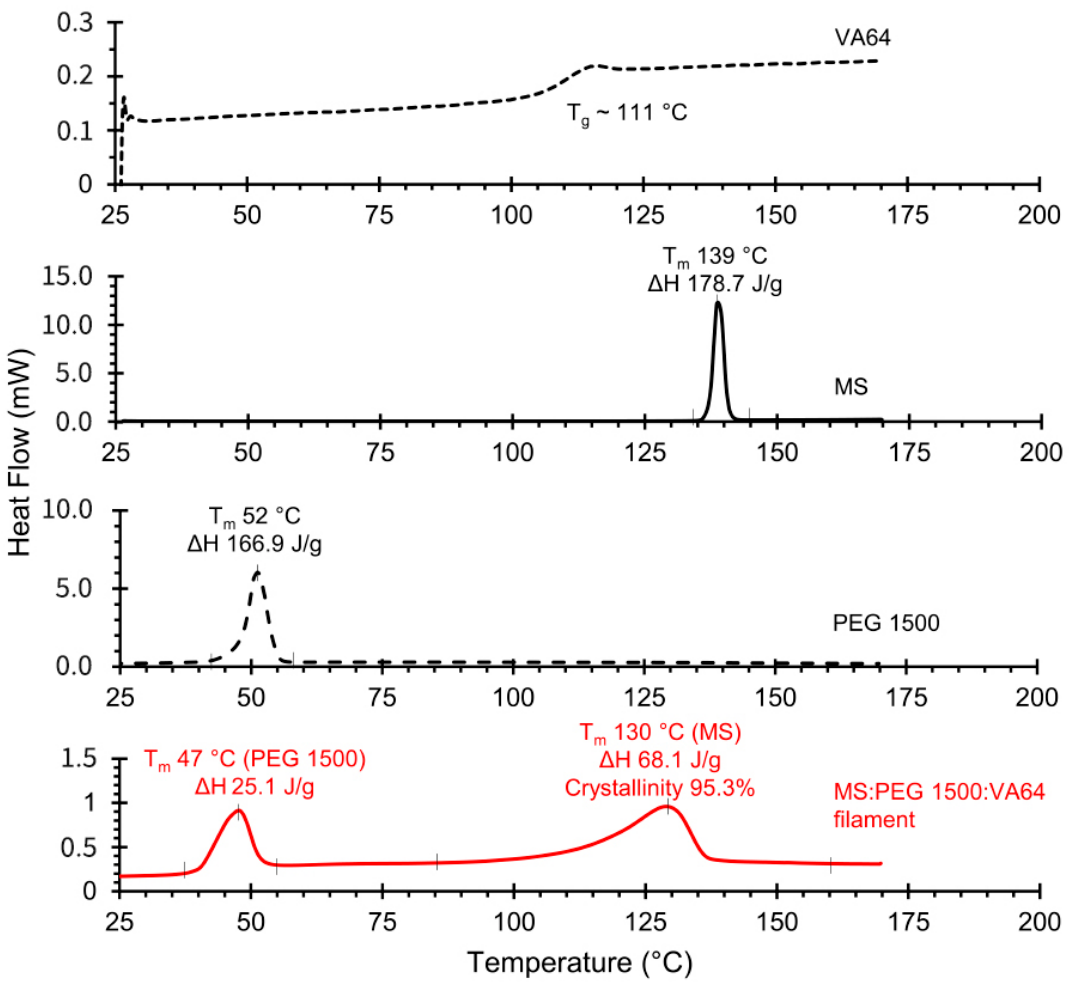
Figure 4. Differential scanning calorimetry (DSC) traces of melt ‐ extruded drug ‐ containing filament (red line) relative to raw materials included in the filament composition (black lines) whilst heating from 25 to 170 °C.